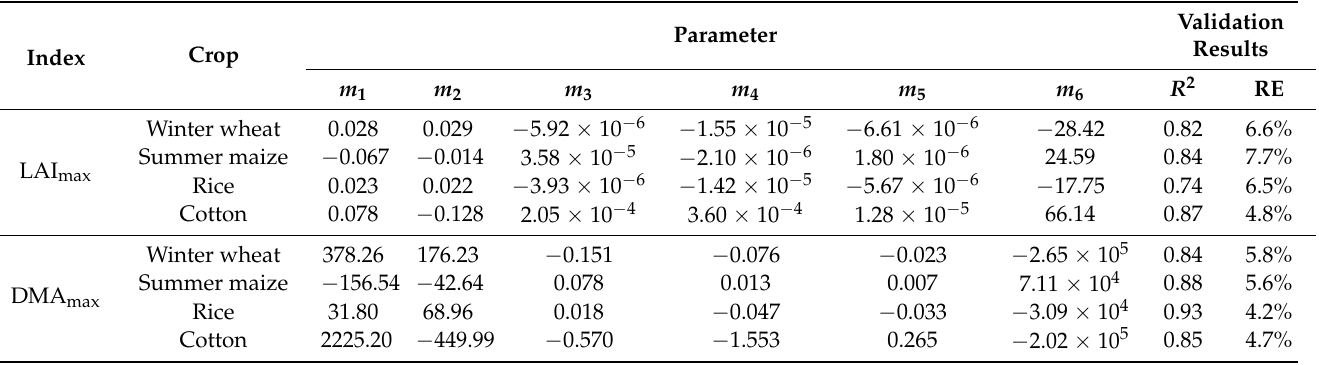
Table 15. Parameters Between Meteorological Factors and the Maximum Values of the Indices of Crop